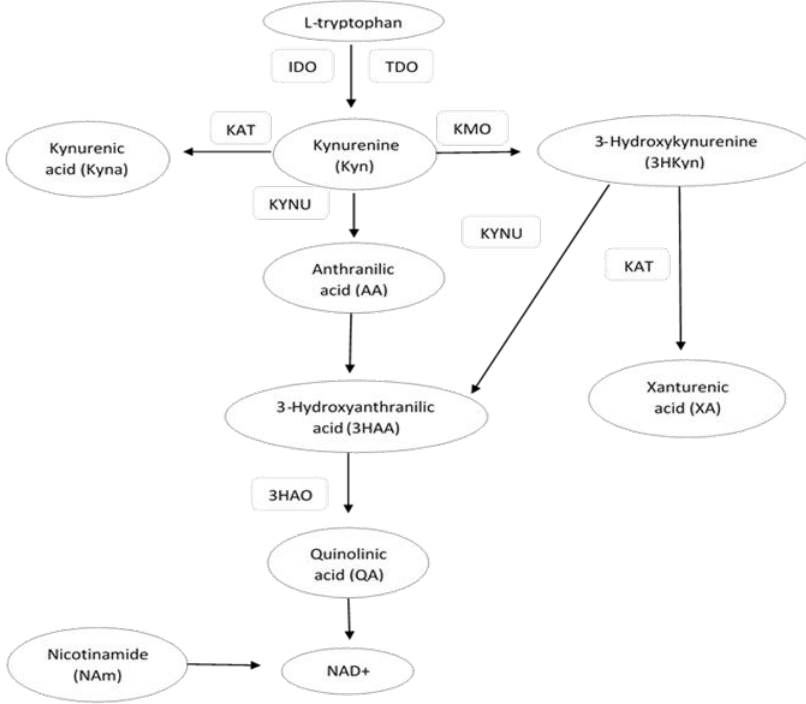
Figure 1. Schematic illustration of some major steps, metabolites, and substrates involved in the kynurenine pathway (KP). IDO — indoleamine 2,3-dioxygenase; TDO — tryptophan 2,3-dioxygenase; KAT — kynurenine aminotransferase; KMO — kynurenine-3-monooxygenase; 3HAO — 3-hydroxyanthranilic acid dioxygenase; KYNU — kynureninase.